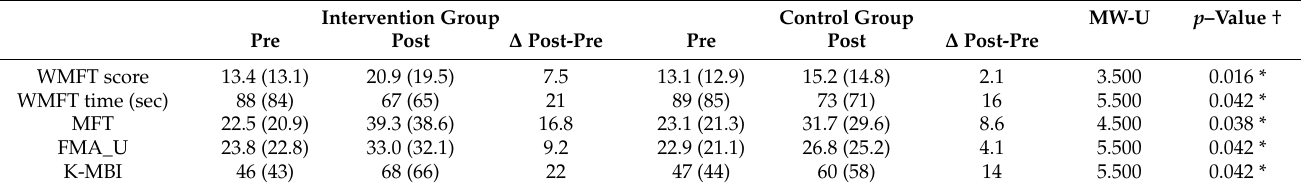
Table 3. Comparison of the outcome measures between the intervention group and the control